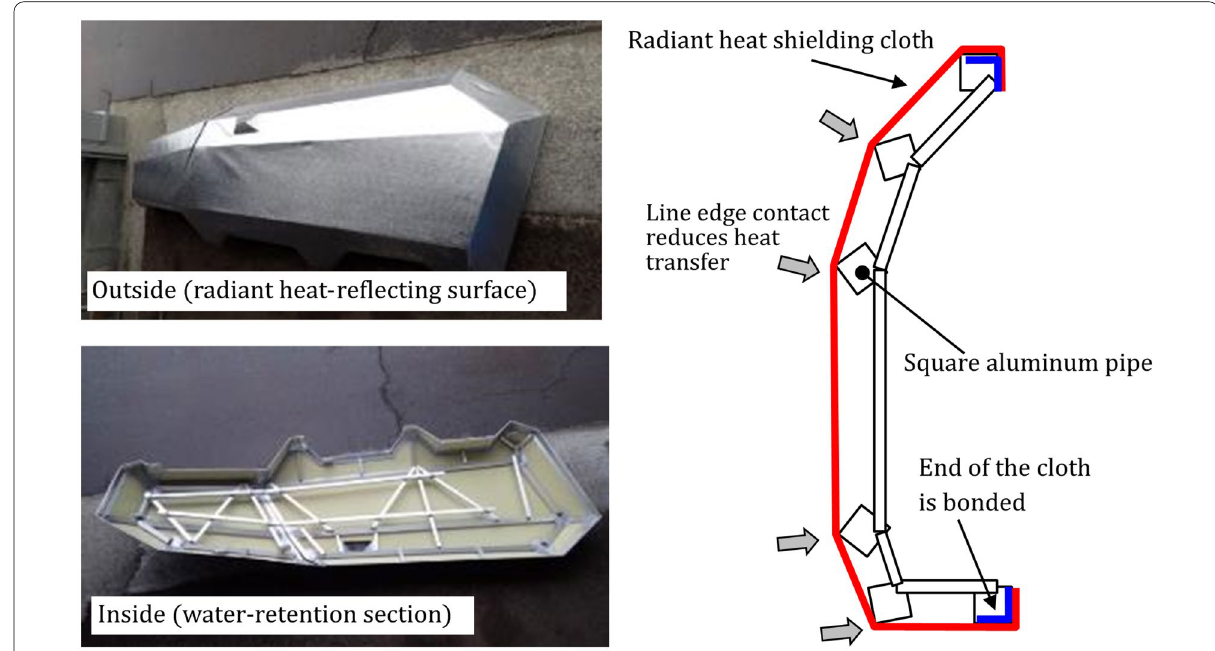
Table 2 Emissivity measurement result of fire protection cloth Number of measurements